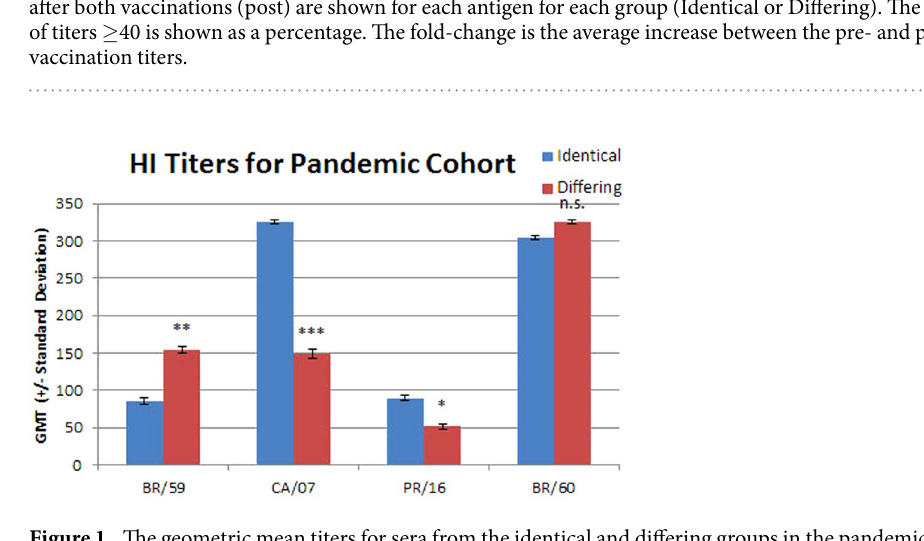
Figure 1. The geometric mean titers for sera from the identical and differing groups in the pandemic shift cohort are shown with standard deviations. The viruses used are listed on the x axis: BR/59, A/Brisbane/59/2007 (H1N1); CA/07, A/California/07/2009 (pdmH1N1); PR/16, A/Perth/16/2009 (H3N2); and BR/60, B/ Brisbane/60/2008 (Victoria). The difference between the identical and differing groups was evaluated using the Mann Whitney rank test. n.s., not significant; * p ≤ 0.05; ** p ≤ 0.01; and *** p ≤